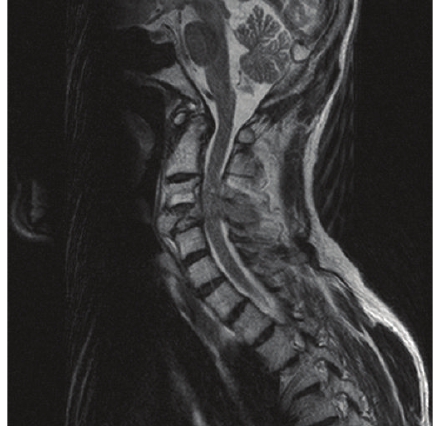
Figure 2: MRI of the cervical spine demonstrating erosive metastatic tumor of the C4 vertebral body.